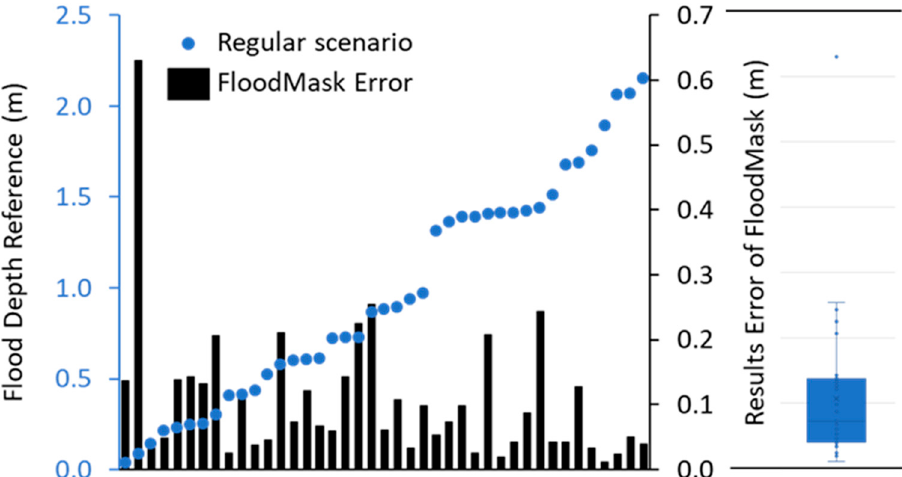
Figure 10. Visual perception flood depth reference data and the error of the FloodMask results with a boxplot in the regular scenario.